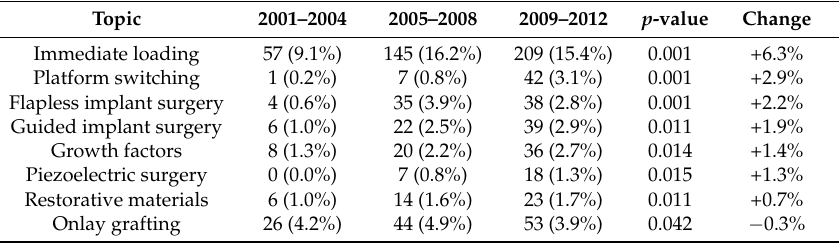
Table 2. Topics demonstrating a significant increase (positive) or decrease (negative change) of scientific interest in the years